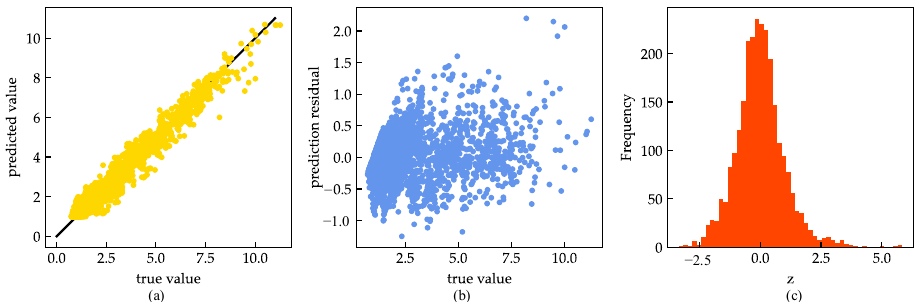
Figure 11. The prediction performance of stacking: ( a ) The scatter plot between predicted value and true value; ( b ) The scatter plot between prediction residual and true value; ( c ) The histogram of z in the model.